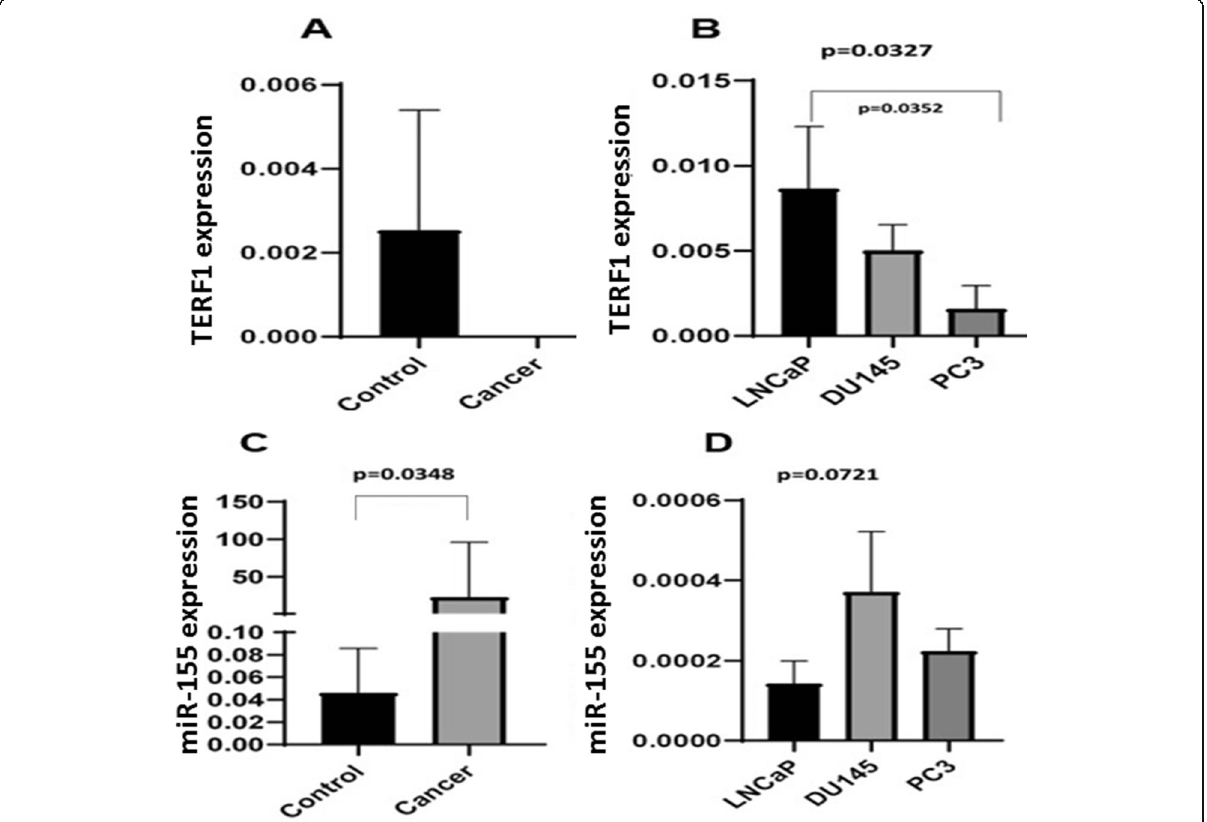
Fig. 5 Upregulation of miR-155 is associated with TERF1 depletion in PC clinical samples and cell lines. A TERF1 gene expression in PC surgical specimens. B TERF1 expression in PC cell lines. C miR-155 expression in surgical specimens. D miR-155 expression in PC cell lines. The graph represents the mean expression in the population with the standard deviation. The y axis is in arbitrary